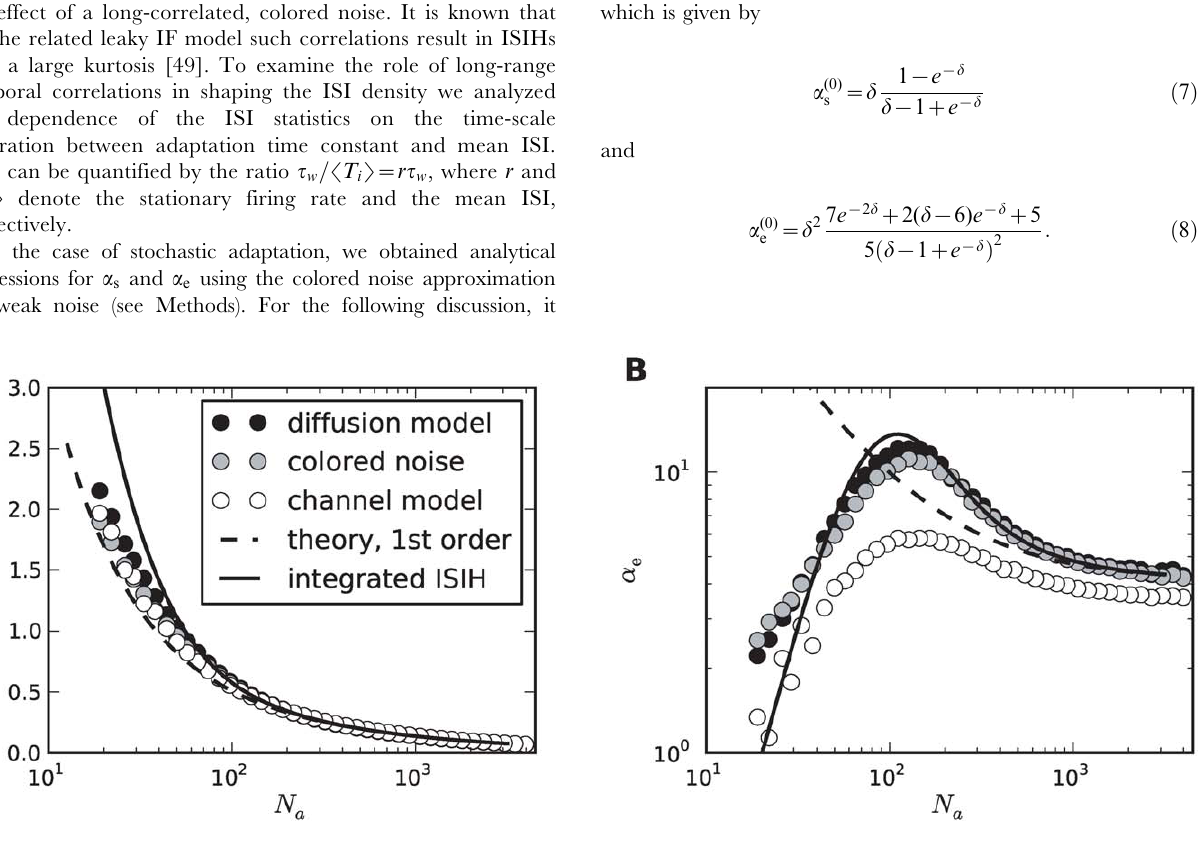
Figure 6. Comparison of diffusion and channel model. A The coefficient of variation as a function of the number of adaptation channels N a for the diffusion model (black circles, Eq. (1)), the channel model (white circles, Eq. (20)) and the colored noise approximation (grey circles, Eq. (4)). The dashed line depicts the theoretical curve Eq. (71) and the solid line depicts the semi-analytical result obtained from the moments of the ISI density, Eq. (69), using numerical integration. B The corresponding curves for the rescaled kurtosis a e . The dashed line represents the theory given by Eq. (114). The time scale separation was r t w ~ t w = S T i T ~ 10 . Parameters as in Fig. 2.